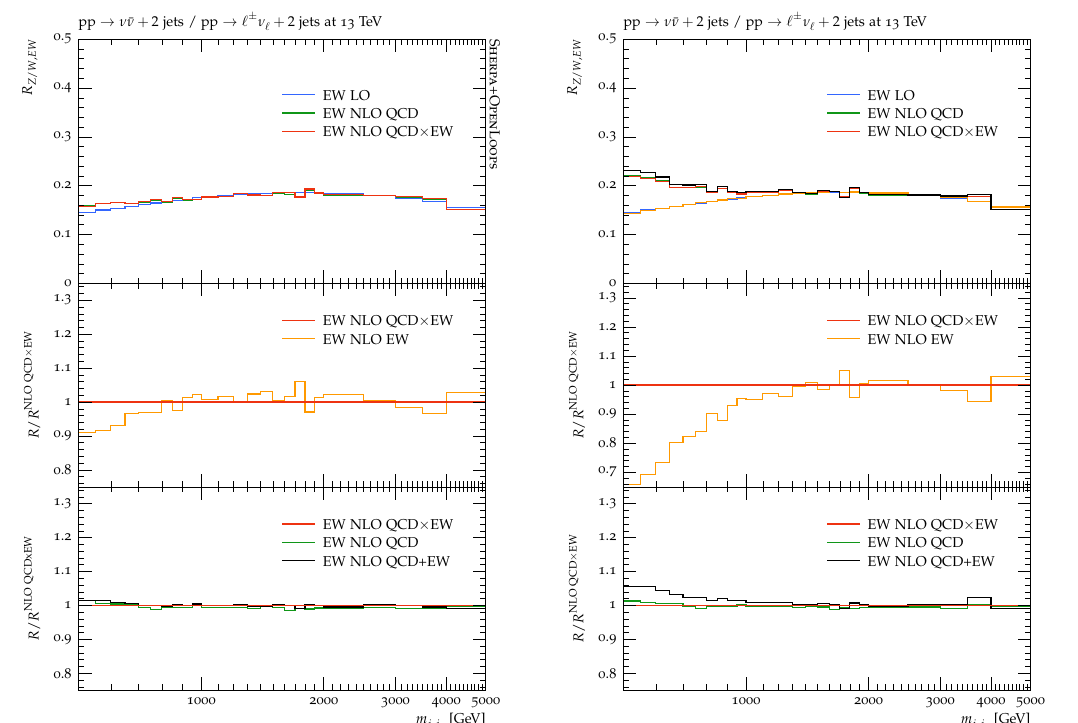
Figure 14. Ratios of the EW pp → Z ( ν ‘ ¯ ν ‘ ) + 2 jets and EW pp → W ± ( ‘ ± ν ‘ ) + 2 jets distributions in m j inclusive (left) and in the presence of the dynamic veto of eq. (3.12) against a third jet 1 j 2 (right). Same higher-order predictions and conventions as in figure 12, but without matching to the parton